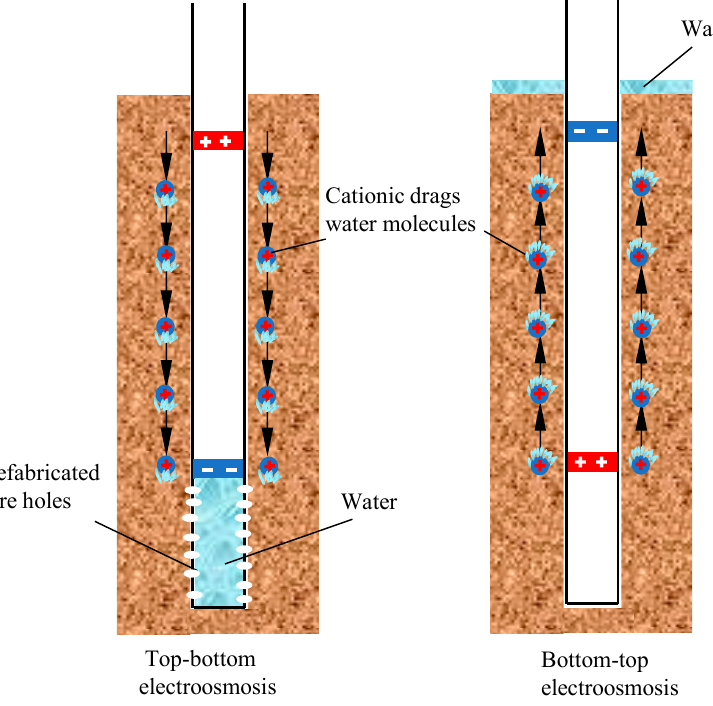
Figure 6. Water flow in electro-osmosis.